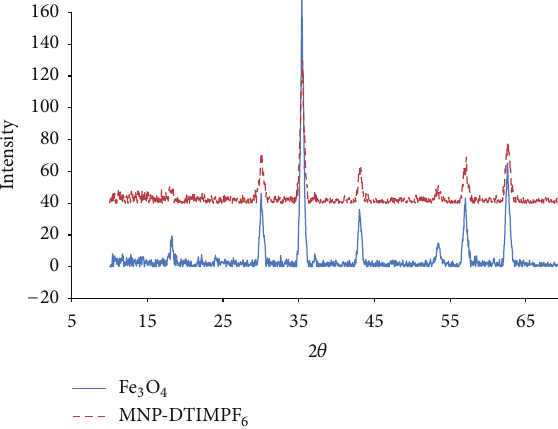
Figure 3: TGA of Fe 3 O 4 and MNP-DTIMPF 6 .